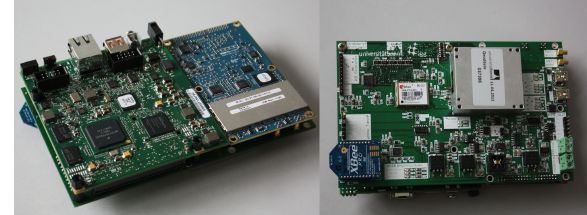
Figure 2: The direct georeferencing system seen from below (left picture) and above (right picture).